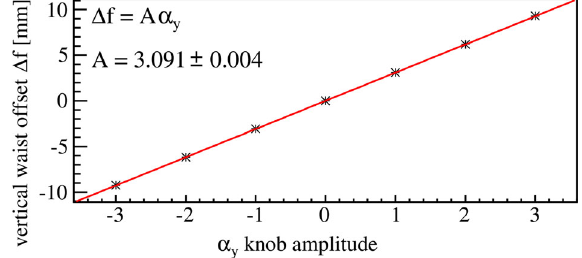
FIG. 5. The relation between α y knob amplitude and beam waist offset derived from the simulations. A is the proportionality